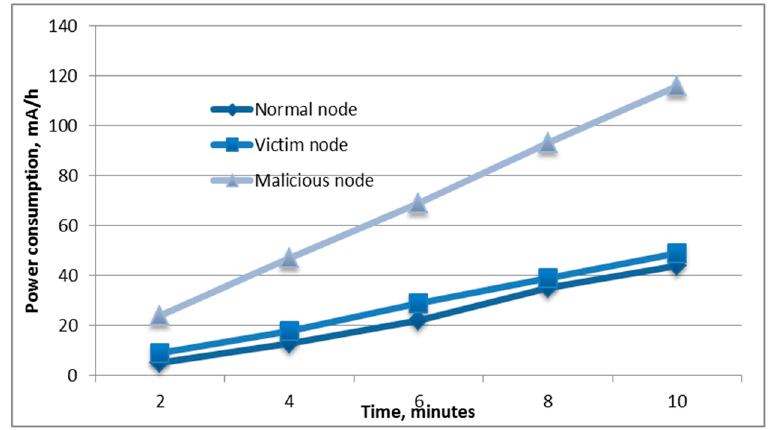
Figure 11. The power consumption of the nodes under the deauthentication attack.